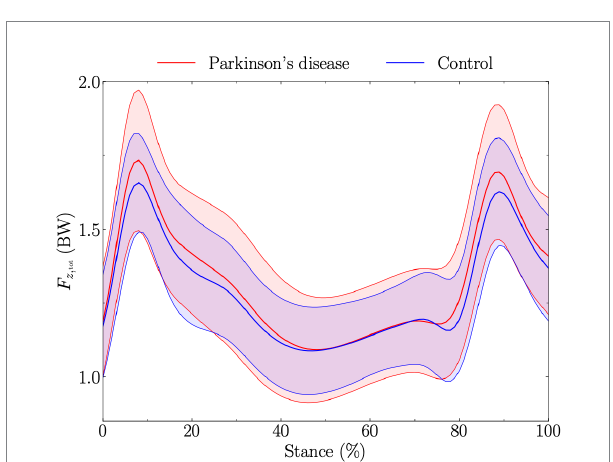
FIGURE 2 Total vertical ground reaction force (obtained by summing the vertical ground reaction force of each foot together; F z ,tot ), expressed in body weight (BW), during stance (from foot-strike to toe-off of the same foot). Solid red and blue lines represent the average for Parkinson’s disease and control groups, respectively, while the standard deviations are given by the shaded areas. The t -test comparing Parkinson’s disease and control groups along the walking stance phase and obtained using statistical parametric mapping was not significantly